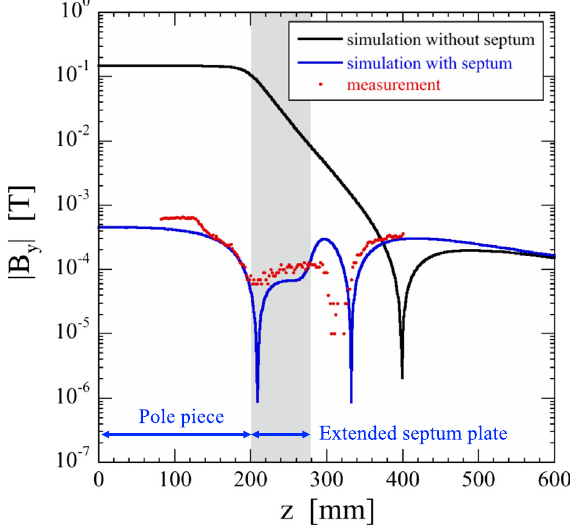
FIG. 15. Longitudinal distribution of magnetic flux density at x ¼ 47 mm. Black and blue lines represent the simulated dis- tribution without and with the septum plate, respectively. Red dots represent the measured data with the septum plate.